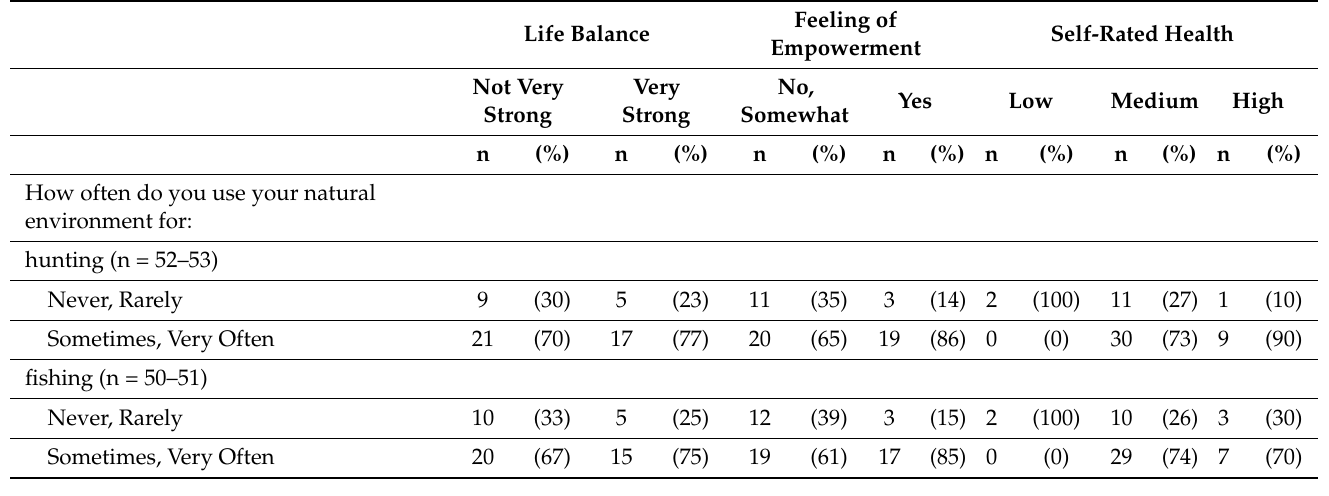
Table 2. Self-rated health, life balance and feeling of empowerment and perceived environmental